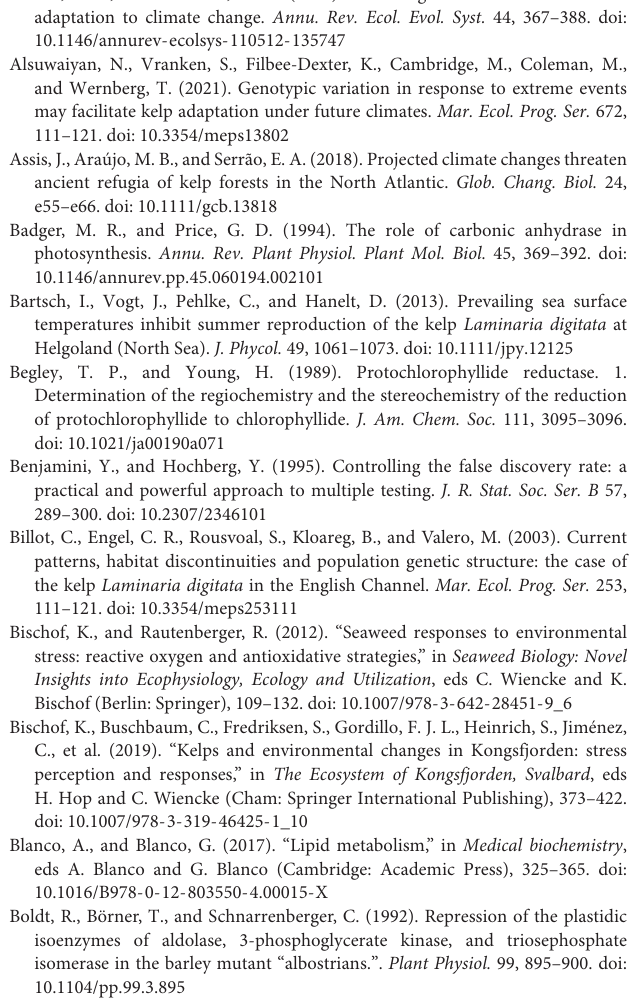
crosses among Helgoland and Spitsbergen Laminaria digitata at 20.5 ◦ C in comparison to 10 ◦ C. Supplementary Table 2 | Differentially expressed KEGG genes common to the comparisons of both reciprocal crosses and one selfing against the remaining selfing at 10 ◦ C, which indicates lineage-specific regulation